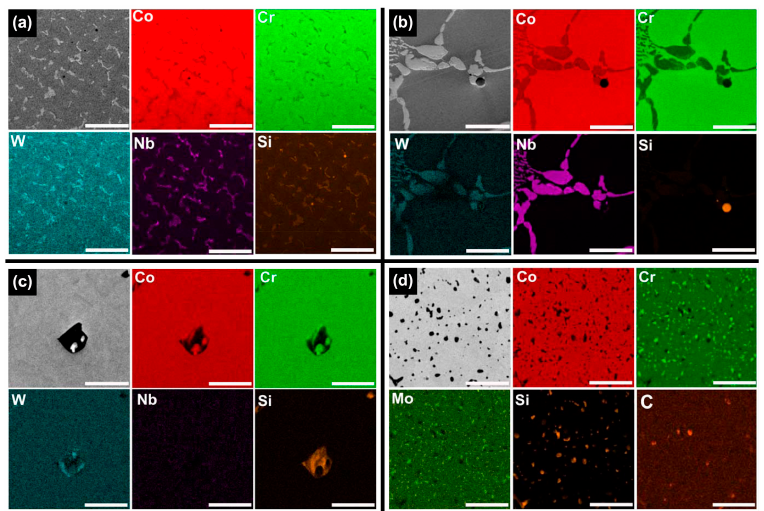
Figure 4. BSE and corresponding EDS mapping images for each group. ( a ) CS; ( b ) ML; ( c ) SLM; and ( d ) ML/PS (500×, scale bar = 50 μ m).